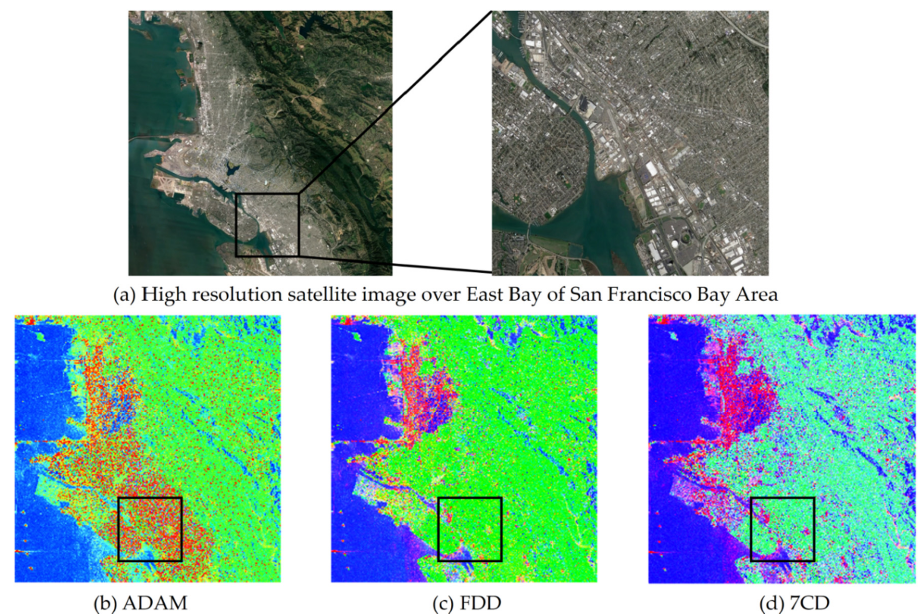
Figure 10. RGB-coded images of the decomposition results of ADAM, FDD, and 7CD with a reference high resolution satellite image over the East Bay of the San Francisco Bay area ( P s —blue; P d —red; and P v —green).